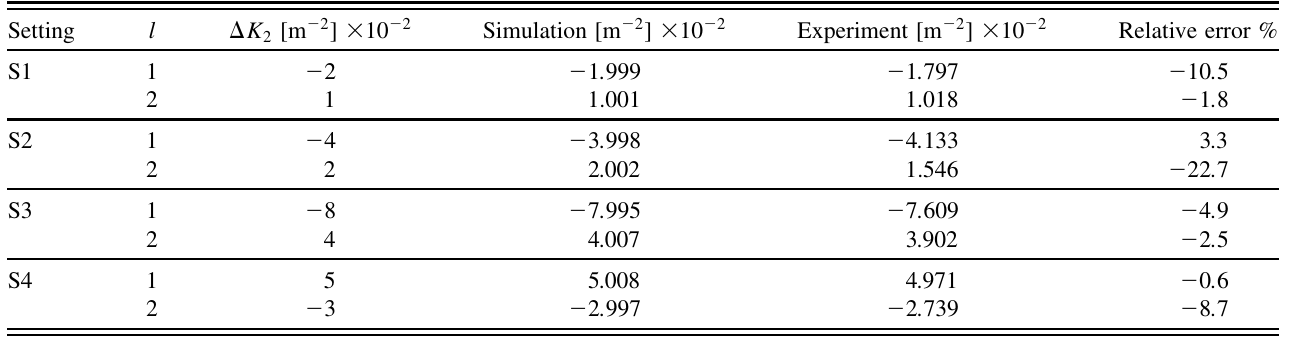
TABLE III. Additional strength applied in the normal sextupoles and retrieved values via NTRM.